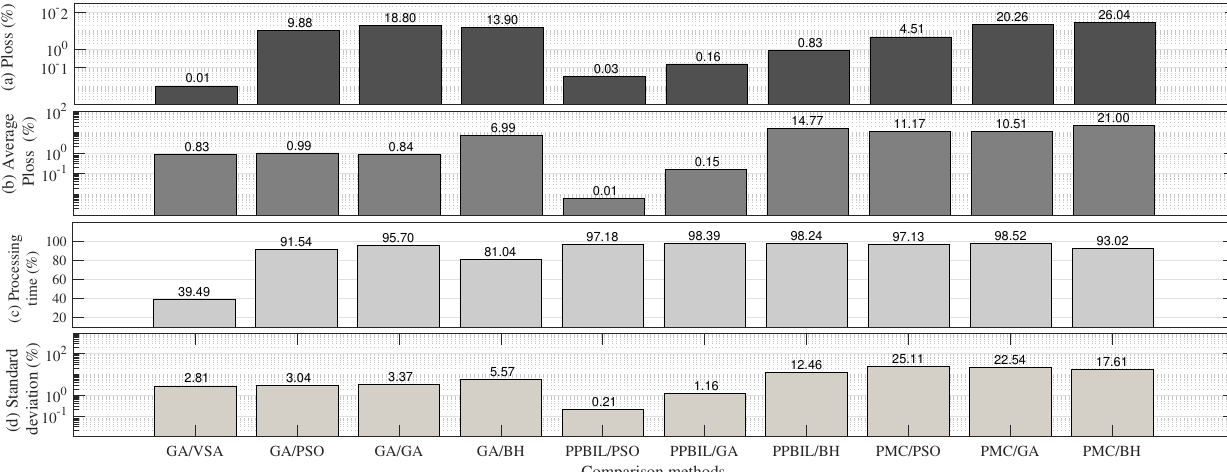
Figure 6. Reductions obtained by the PPBIL–VSA methodology with respect to the comparison methods in the 21-bus test